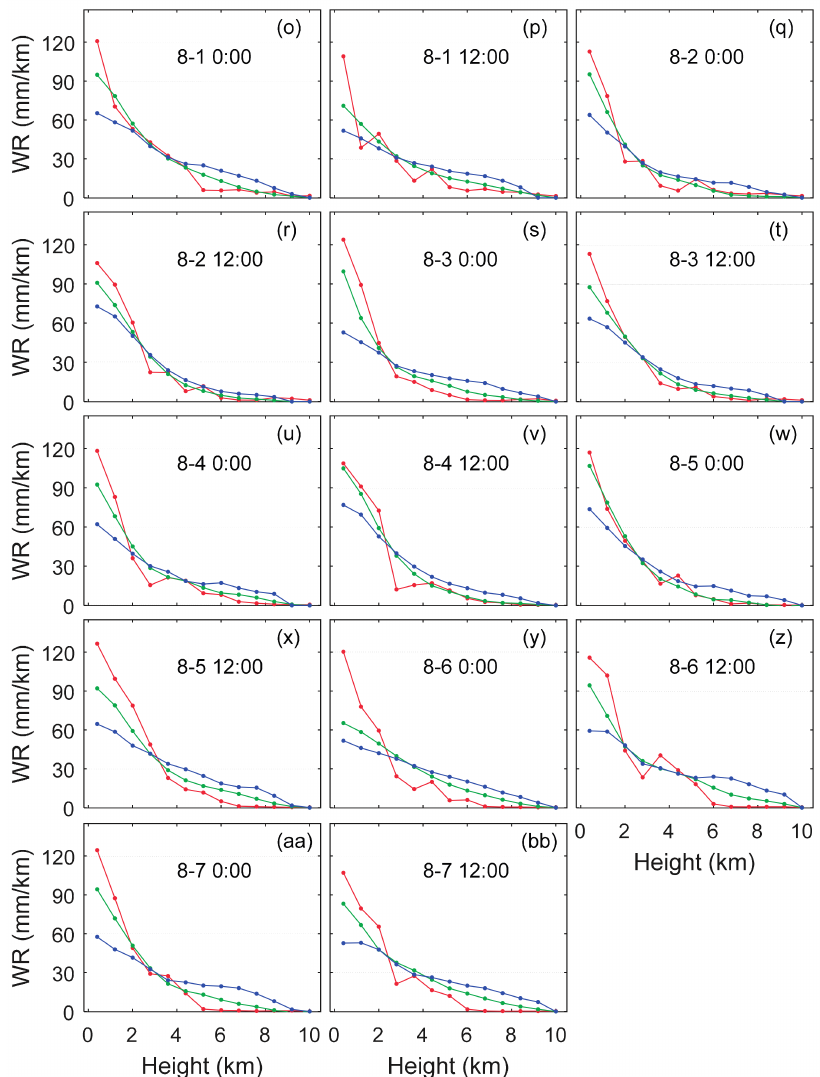
Figure 3. Vertical wet refractivity from radiosonde data, ALS method and CLS constrained results. ( a – n ): WR results during rainy period; ( o – bb ): WR results during rainless